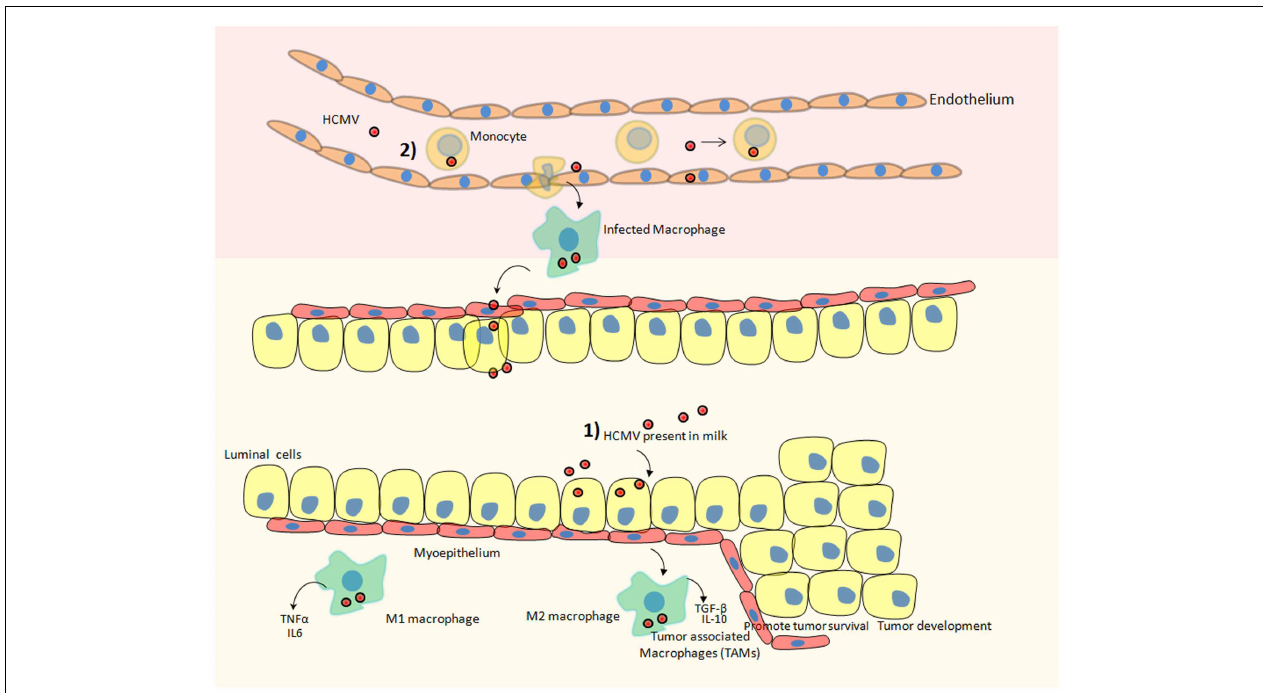
tissue, HCMV-infected macrophages could transmit the virus to mammary epithelial cells. Additionally, monocytes/macrophages are regarded as a prominent reservoir of HCMV infection. HCMV infection of monocytes/macrophages can reprogram them to acquire M1/M2 characteristics. M1 macrophages secrete pro-inflammatory cytokines and M2 macrophages secrete immuno-suppressive factors that can promote the progression of breast cancer.Tumor-associated macrophages (TAM) that are of poor prognosis during breast cancer and fuel the progression of the disease could be preferentially activated by